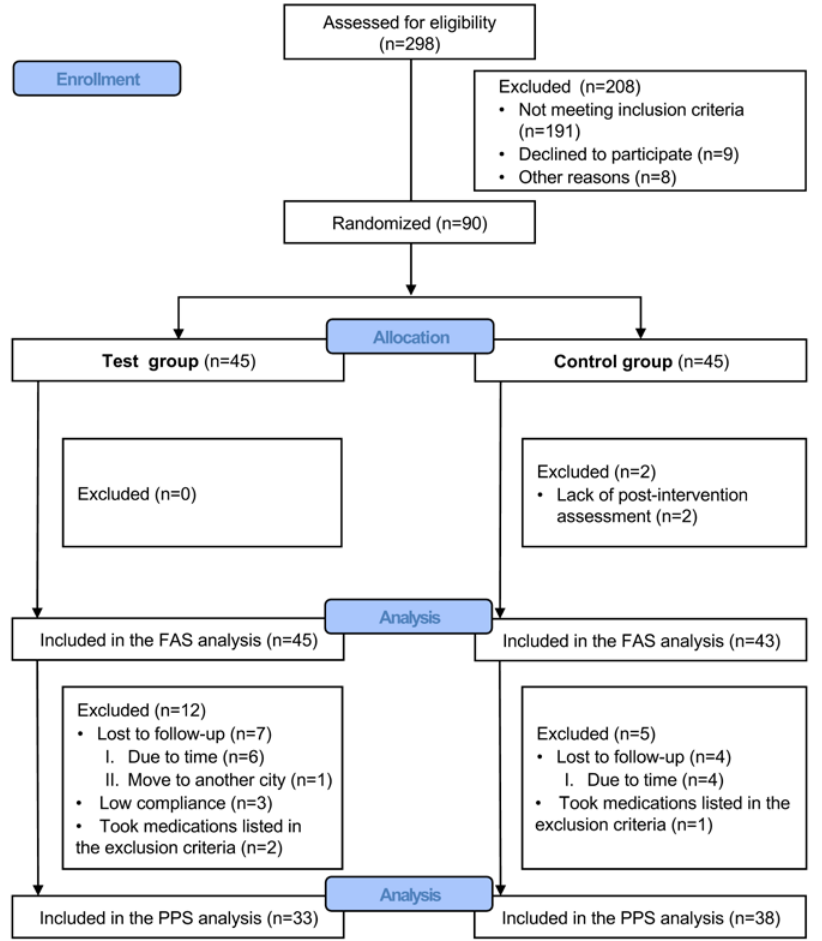
Figure 1. CONSORT flow diagram of the trial. FAS, full analysis set; PPS, per-protocol set.